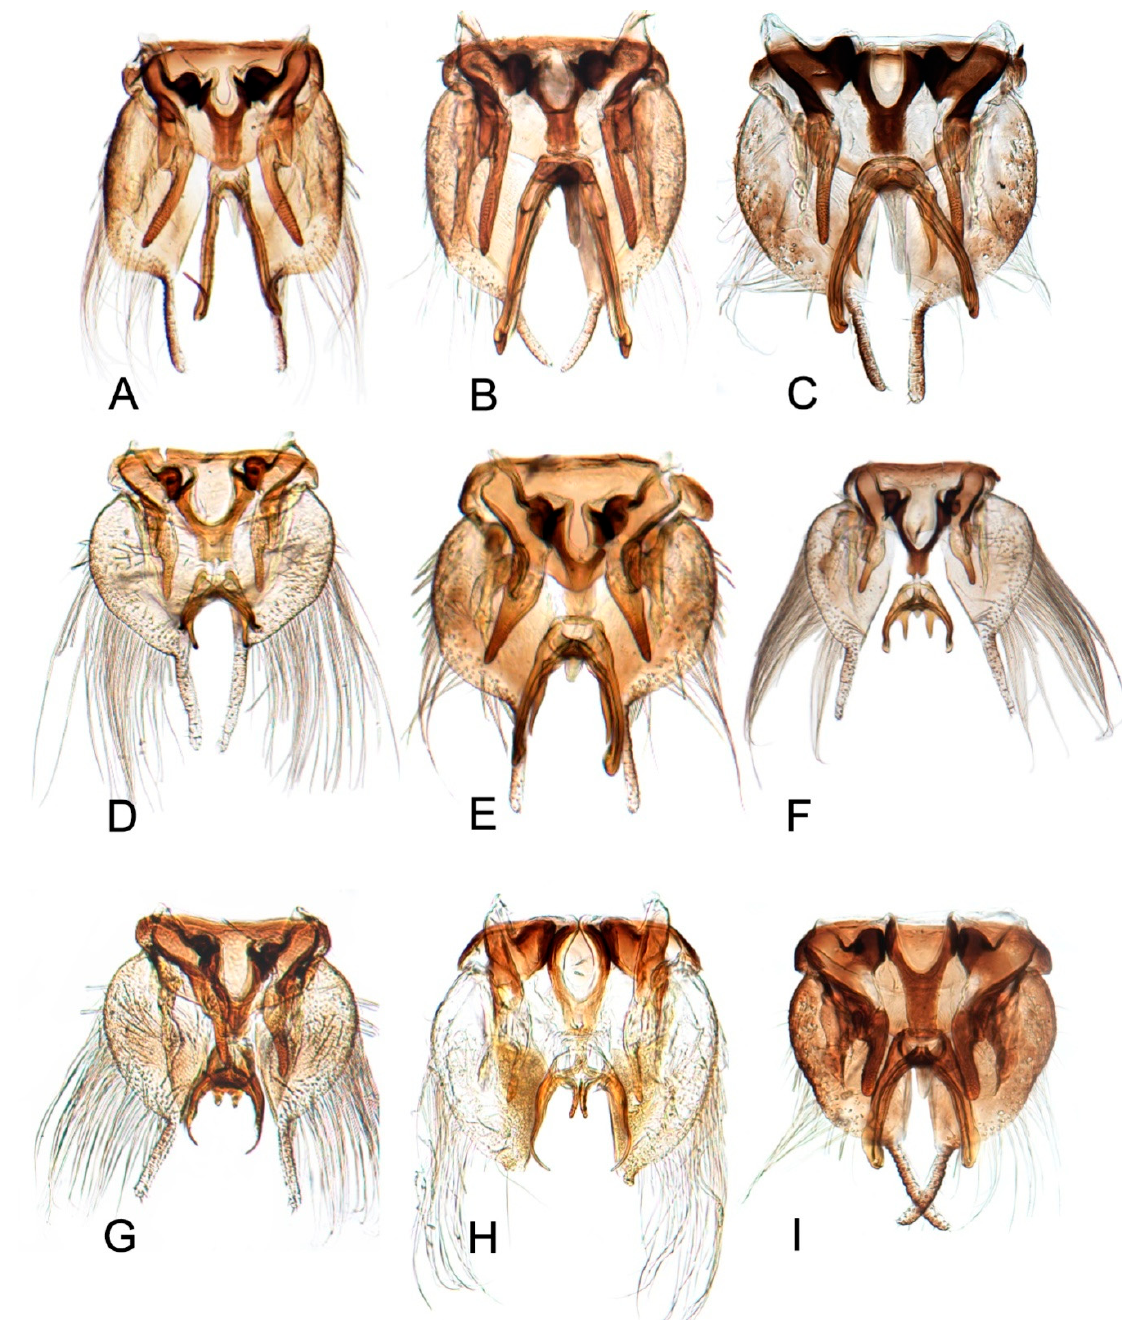
Figure 11. Subgenital plate, valve, style, connective, and aedeagus, dorsal view. (A) H. prolongatus ; (B) H. spiniferous ; (C) H. kuohi ; (D) H. tortuosus ; (E) H. aberrans ; (F) H. knightiellus ; (G) H. tenuis ; (H) H. subtilis ; and (I) H. diffractus .